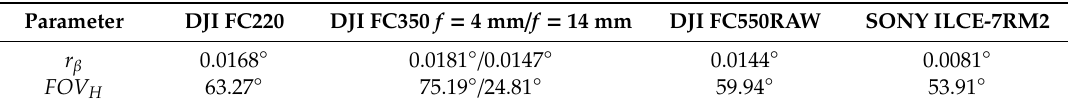
Table 2. Horizon slope measurement resolution 𝑟 𝛽 and horizontal field of view 𝐹𝑂𝑉 𝐻 calculated for